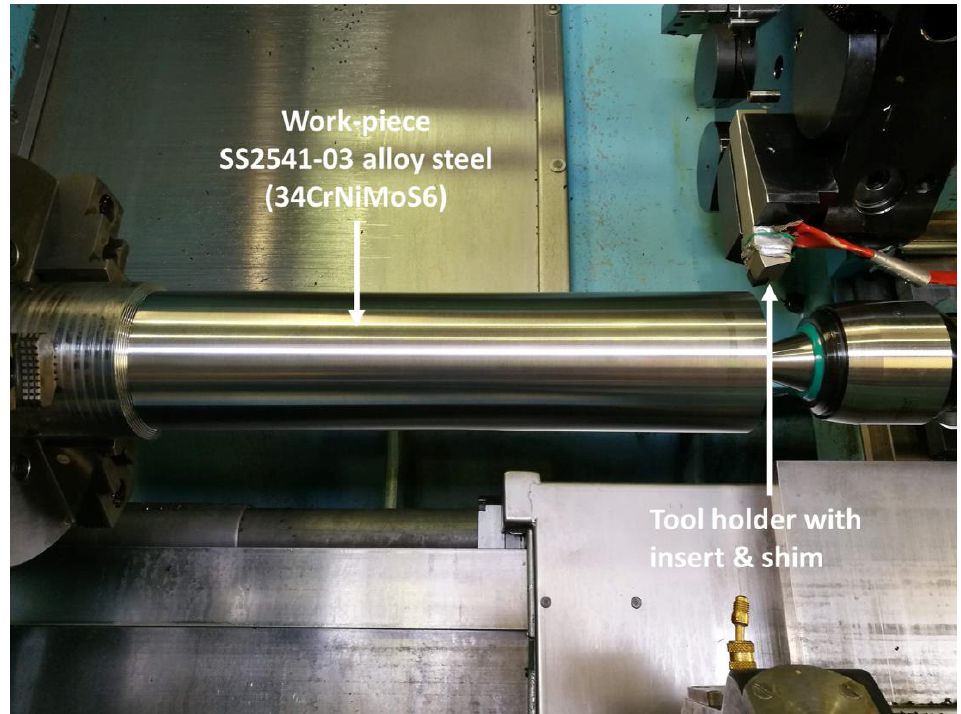
Figure 4. External turning in SMT Swedturn machine. Parameters: cutting speed Vc = 220 m/min, feed rate f = 0.35 mm/rev, and depth of cut a p = 1.2 mm.